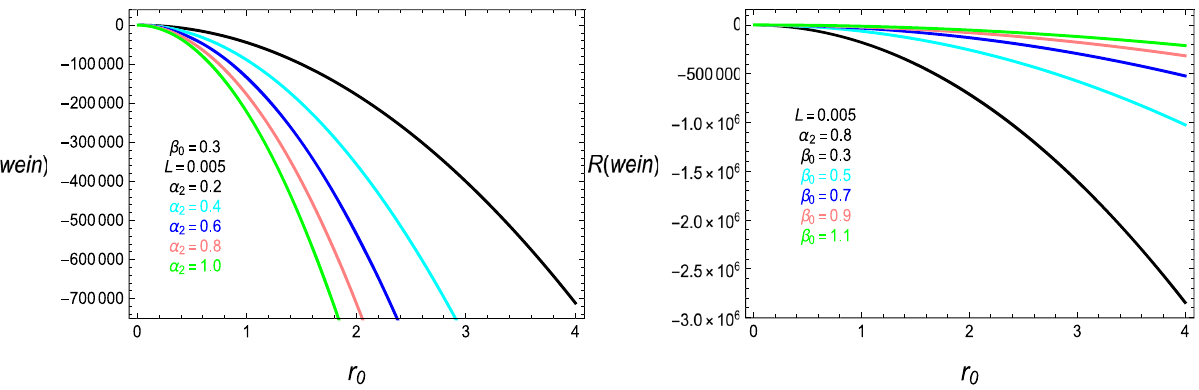
Fig. 4 Wein Hold geometry R (w en ) plots, for β 0 = 0 . 3 , L = 0 . 005 , α 2 = ( 0 . 2 , 0 . 4 , 0 . 6 , 0 . 8 , 1 . 0 ) {left} and α 2 = 0 . 8 , L = 0 . 005 , β 0 = ( 0 . 3 , 0 . 5 , 0 . 7 , 0 . 9 , 1 . 1 )